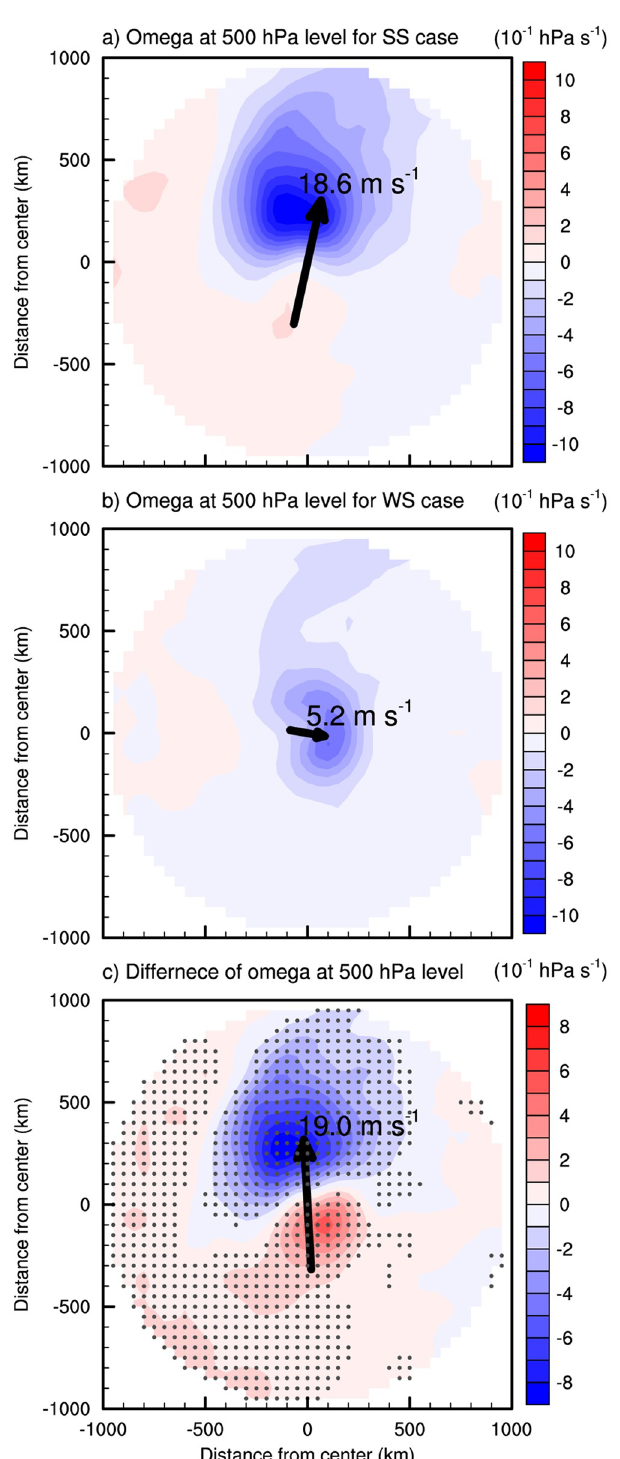
Fig 8. The vertical velocity (shaded, unit: 10 − 1 hPa s -1 ) at 500 hPa level and the vertical wind shear vector (arrow, unit: m s -1 ) in the (a) SS case, (b) WS case, and (c) their differences (SS minus WS) during the landfall periods. The directions of x- and y- axis are right and front to TC motion, respectively. The gray dots indicate the statistically significant differences at the 95% confidence level evaluated with Student’s t -test.